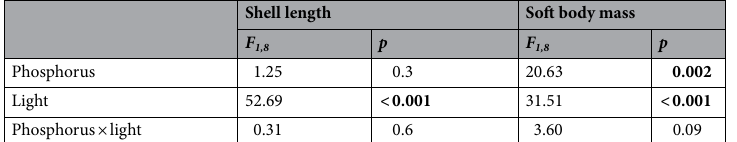
Table 4. Results of two-way ANOVAs on the effects of phosphorus and light on snail shell length and soft body mass at the end of the grazing phase. Significant effects ( p < 0.05) are highlighted in